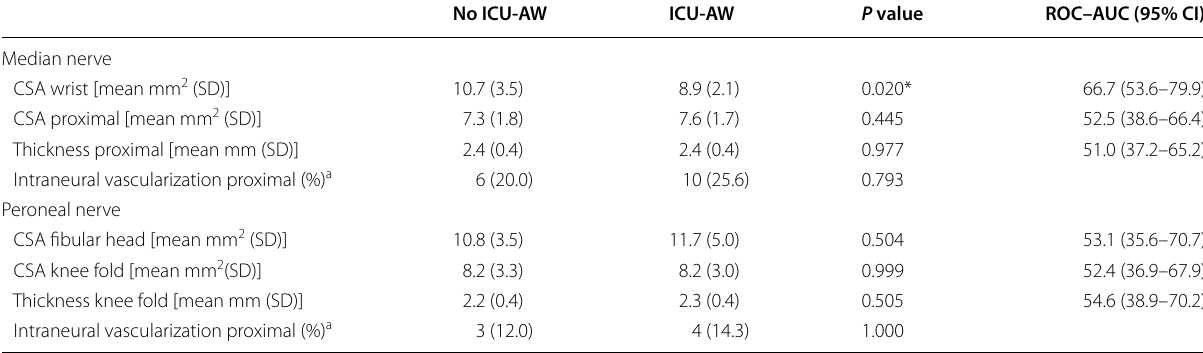
* P < 0.05 a In transversal or longitudinal